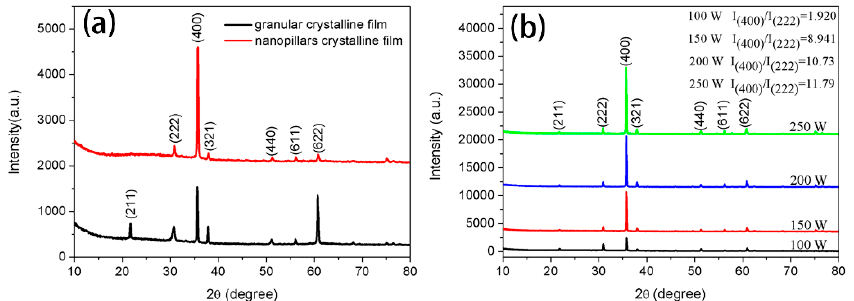
Figure 2. ( a ) X-ray diffraction (XRD) patterns of monolayer granular crystalline and monolayer nanopillar crystalline ITO thin film; ( b ) XRD patterns of multiple structure nanopillar crystalline indium tin oxide (ITO) thin film deposited at different powers.